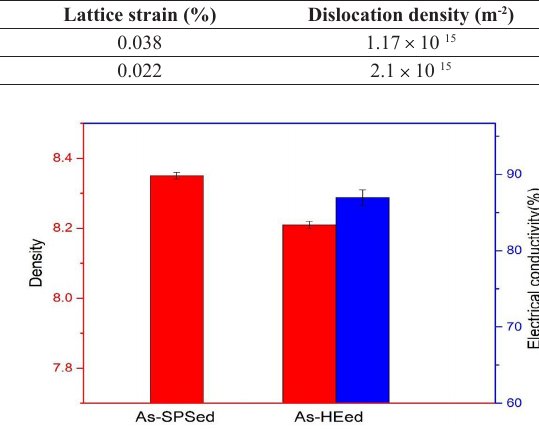
Figure 2. The density and the electrical conductivity of the